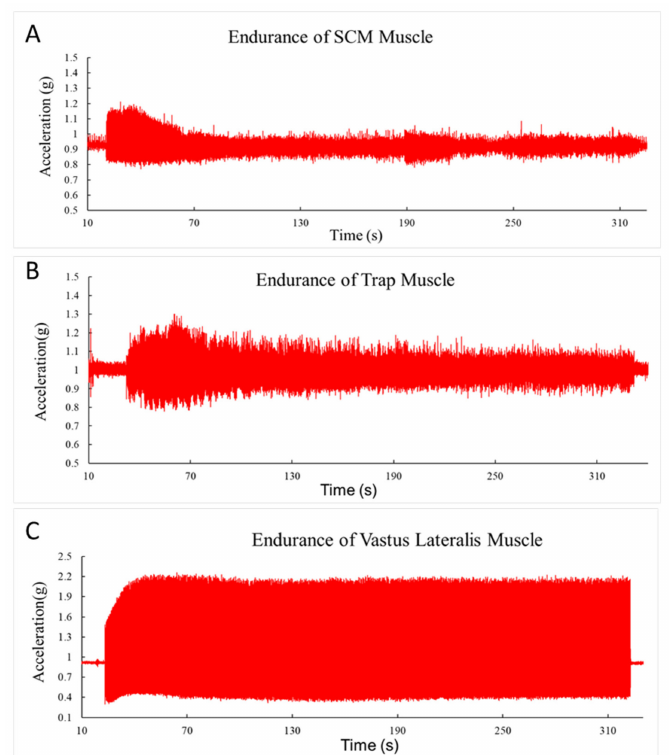
Figure 2. ( a ) Representative examples of 5-min endurance tests for the sternocleidomastoid muscles at 5 Hz. The decrease in acceleration overtime is calculated as the endurance index (EI). The y-axis is the acceleration (g) and the x-axis is time (secs). ( b ) Representative examples of 5-min endurance tests for the trap muscles at 5 Hz. The decrease in acceleration overtime is calculated as the endurance index (EI). The y-axis is the acceleration (g). ( c ) Representative examples of 5-min endurance tests for the vastus lateralis muscles at 5 Hz. The decrease in acceleration overtime is calculated as the endurance index (EI). The y-axis is the acceleration